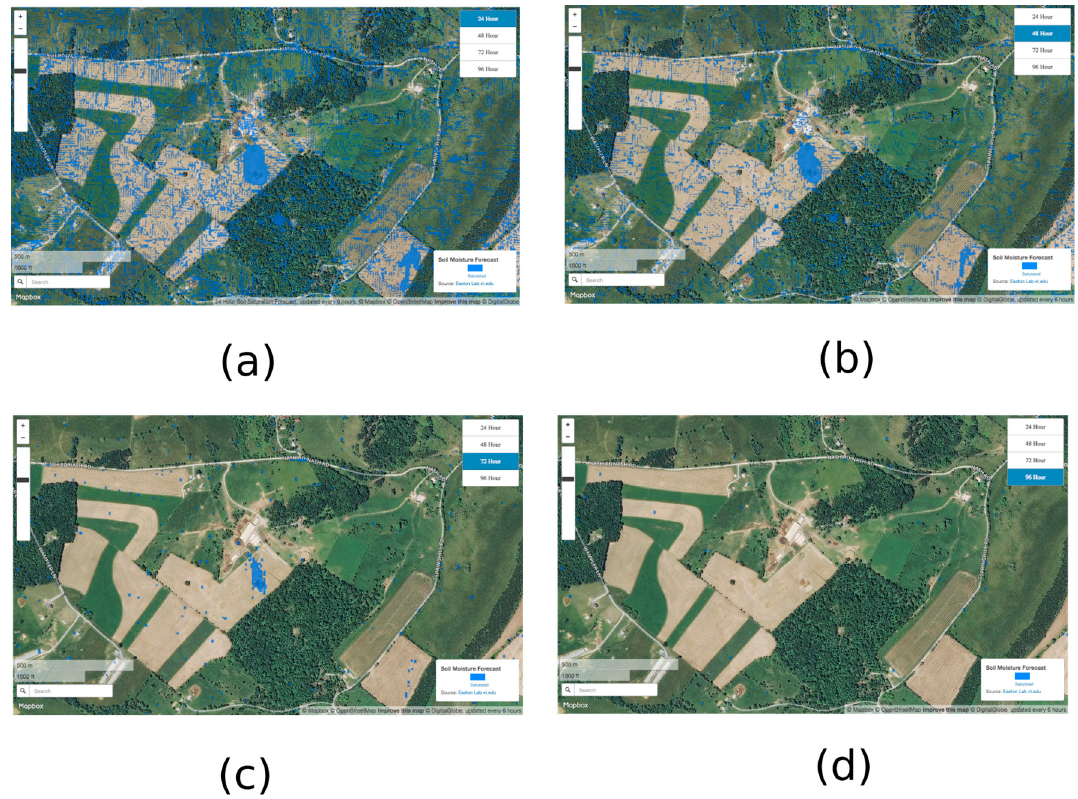
Figure 2. DSS showing a soil saturation forecast for 24 ( a ), 48 ( b ), 72 ( c ), and 96 ( d ) over farm fields west of Harrisonburg, Virginia. At the center of each screen shot, a large, concentrated area of soil saturation can be seen. Over the forecasts the extent of the area decreases, indicative of a forecasted precipitation then drying period. This illustrates the capability of the DSS to provide daily, sub-field resolution forecasts that communicate the variable nature of NPS pollution in the study area region. Table 2. Google PageSpeed Insights